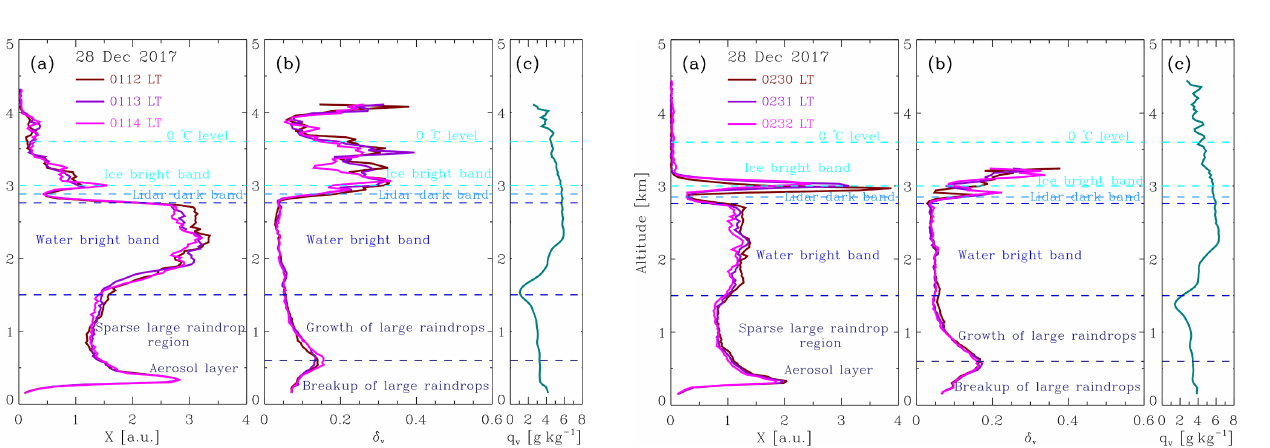
Figure 3. Sequential profiles of (a) temperature T , (b) relative humidity over liquid-water RH, (c) water vapor mixing ratio q v and (f) the eastward u (dotted) and northward v (solid) wind components delivered by conventional radiosonde measurements (twice daily) released on 26–28 December 2017 at the Wuhan weather station ( ∼ 23.4km away from our lidar site). Also shown are the corresponding profiles of the (d) range-corrected signal X and (e) volume depolarization ratio δ v measured by the 355nm polarization lidar on 26–27 December 2017. The different curve colors in each panel represent the radiosonde release times, as shown in panel (c) . Each colored lidar profile represents a 1h integration centered at the radiosonde release time marked in panel (d) . The radiosonde profiles quantitatively present the meteorological conditions that are pertinent to the warm-front cloud at different stages and during precipitation.